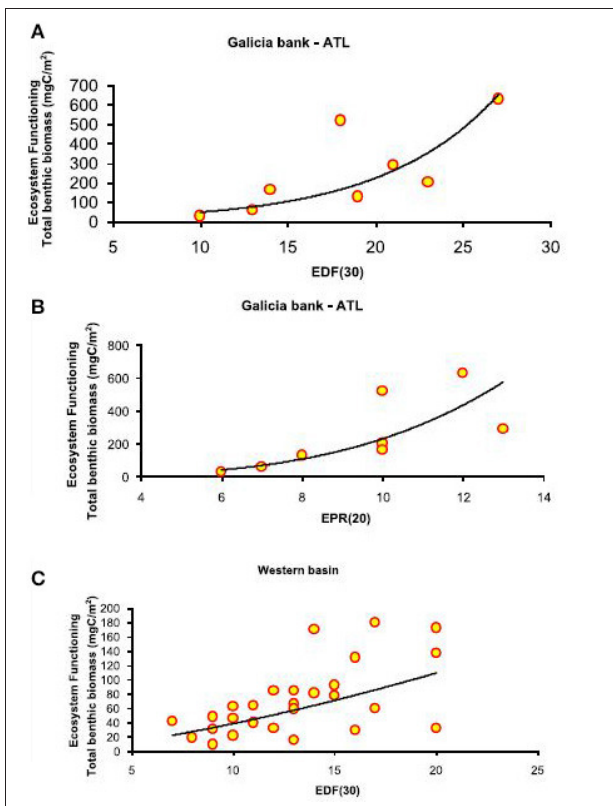
FIGURE 4 | Basin-scale relationships between macrofauna functional diversity and ecosystem functioning. Relationship between functional diversity, expressed as expected richness of deposit feeders (EDF (30) ) and expected predator richness (EPR (20) ), and ecosystem functioning, expressed as total benthic biomass (mgC/m 2 ). The equations of the fitting line are respectively (A) y = e ∧ (6.67 − 4.83 x ) ( N = 9; R 2 = 0.98; p < 0.01) and (B) y = x ∧ 2.71 ( N = 9; R 2 = 0.61; p < 0.05) in the Atlantic Ocean and (C) y = e ∧ ( − 1.60 + 2.82x) ( N = 27; R 2 = 0.98; p < 0.01) in the Western Mediterranean